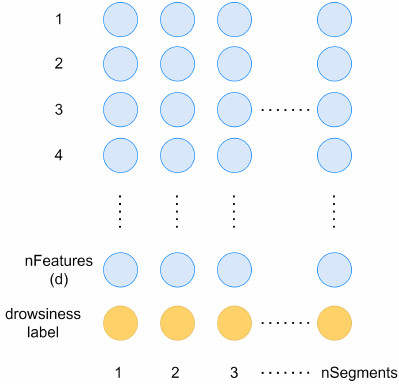
Figure 7. The process of feature extraction from time-domain EEG segments.